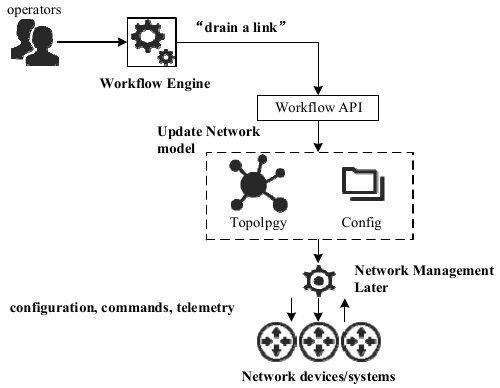
Figure 1. The zero-touch network architecture.